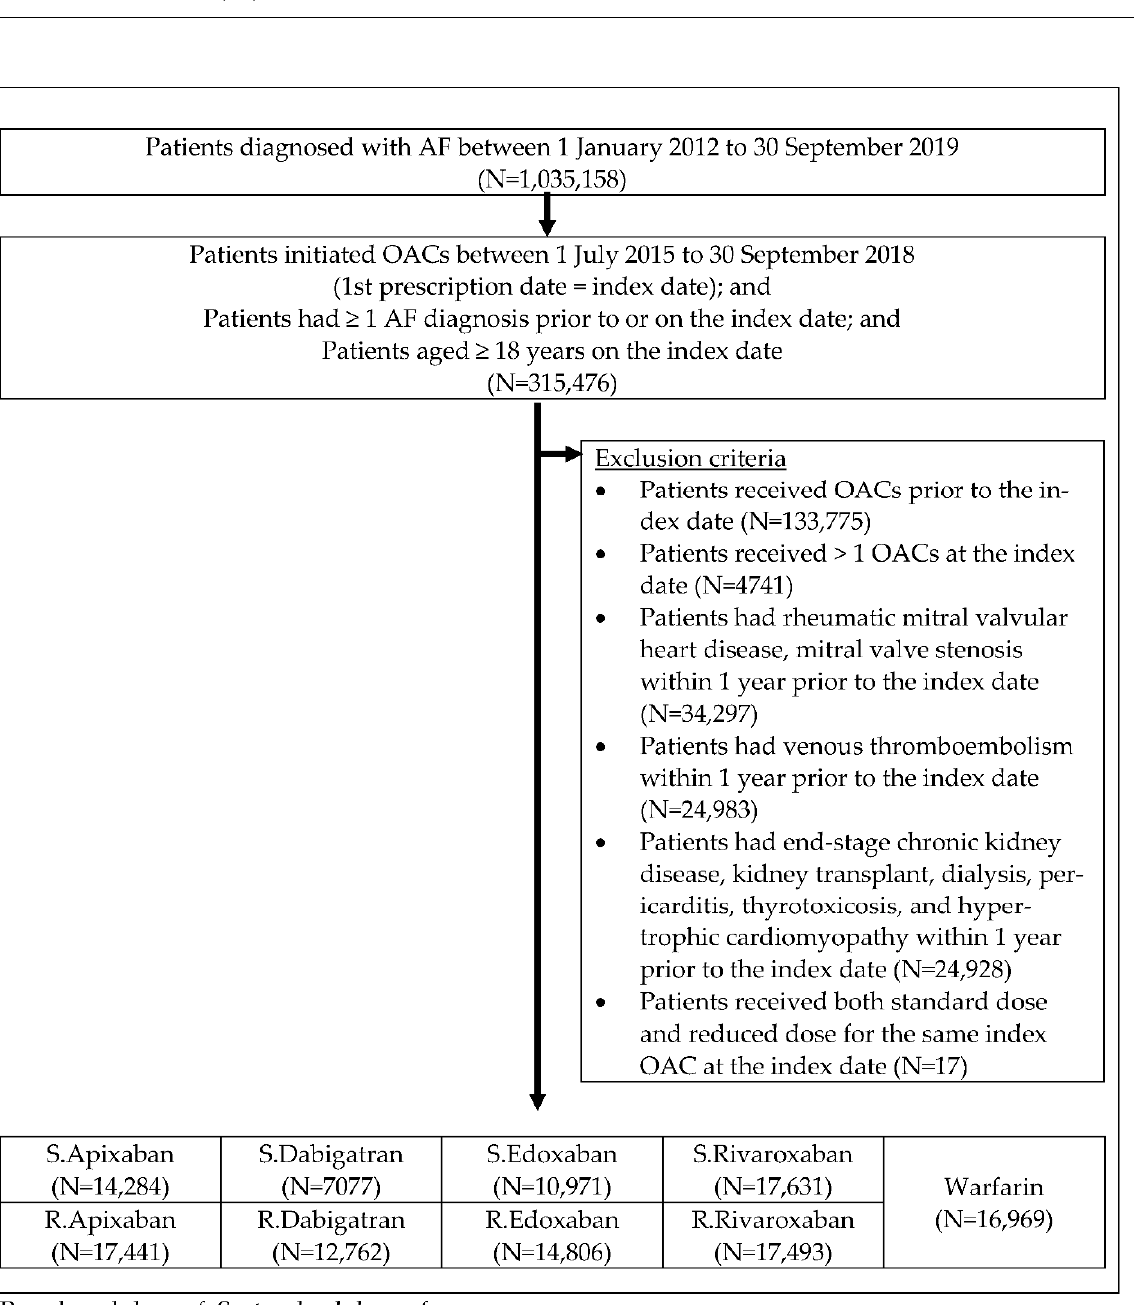
Figure 2. Patient-selection flow.